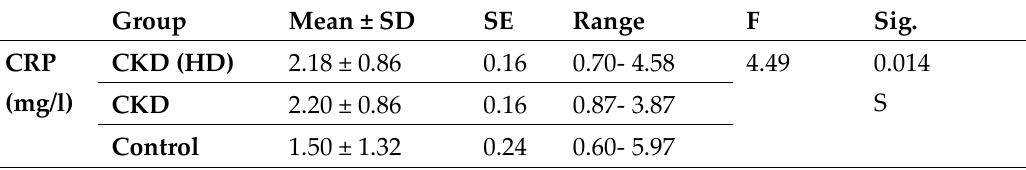
Table 6: Mean salivary CRP of study groups with ANOVA